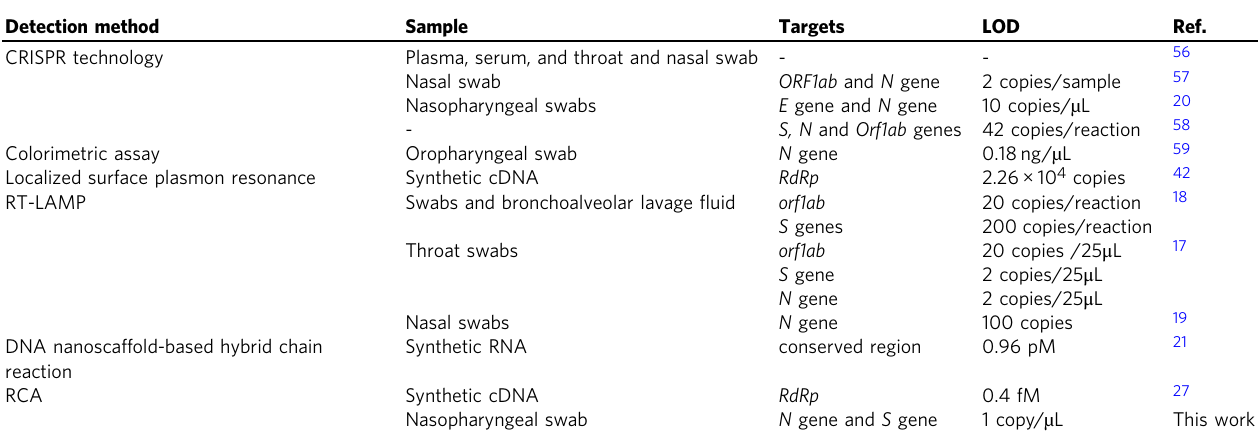
Table 1 Sensitivity of commercially available test kits and existing biosensors for COVID-19 testing. Detection